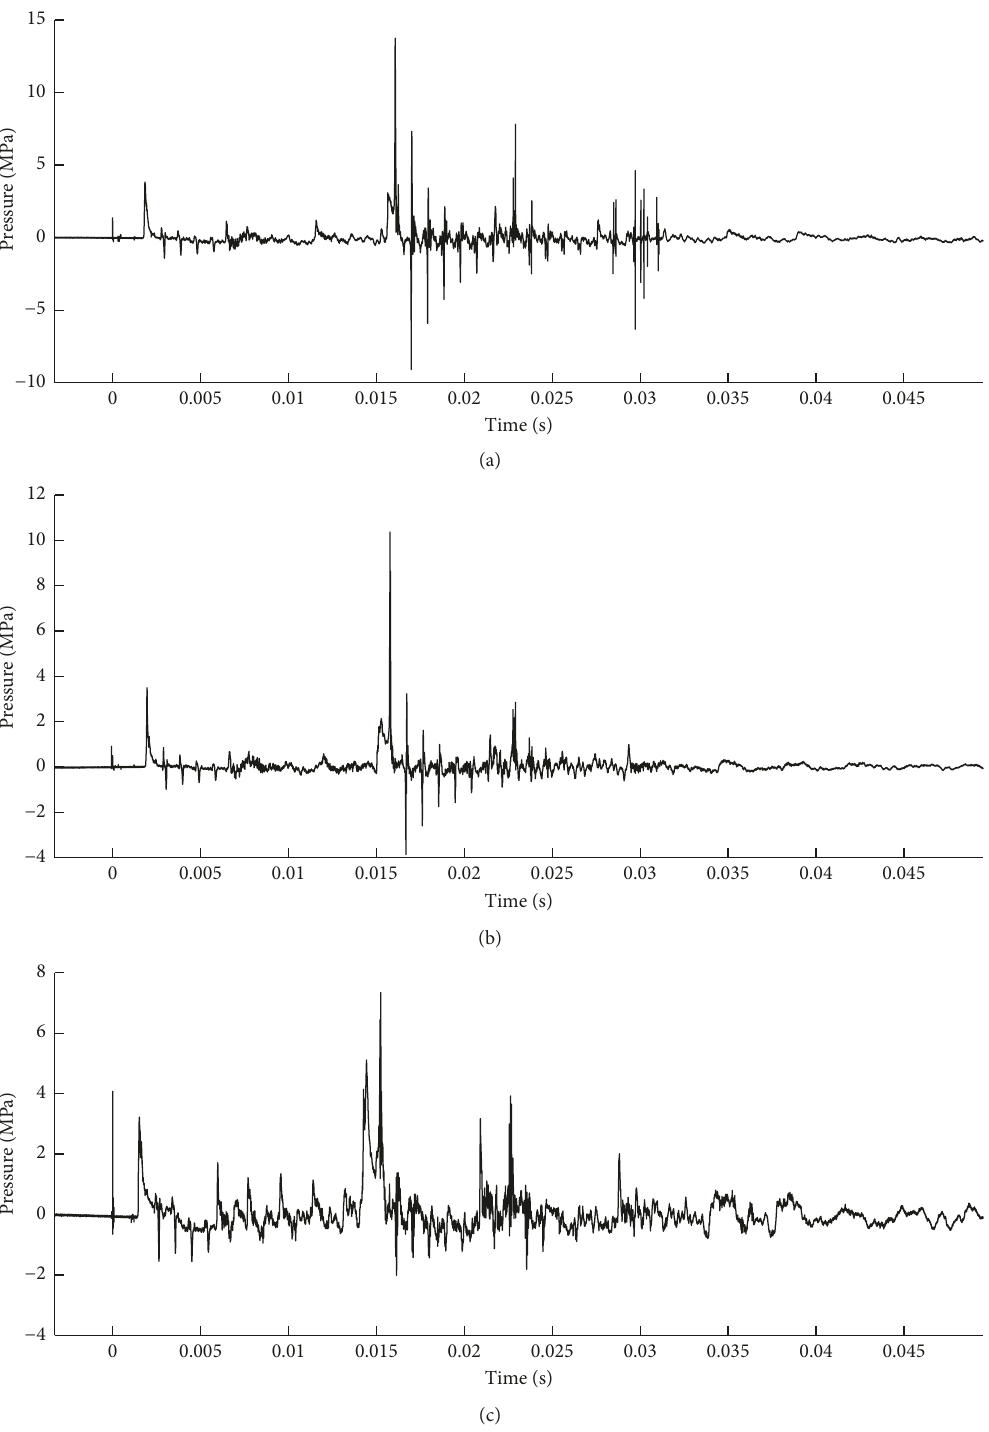
Figure 14: Pressure-time profile recorded by HPB with (a) 25 mm, (b) 30 mm, and (c) 35 mm